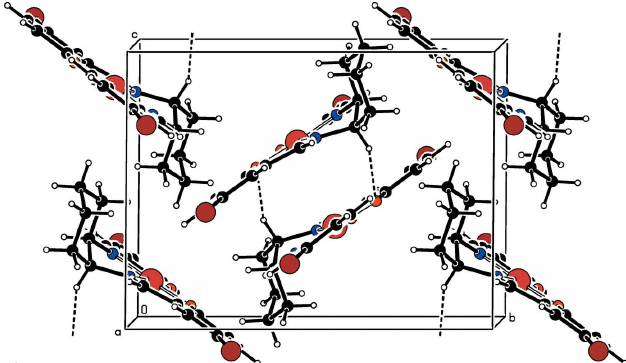
Figure 2 The packing in the crystal structure of the title compound, viewed approximately along the a axis. Hydrogen-bonding interactions are drawn as dashed